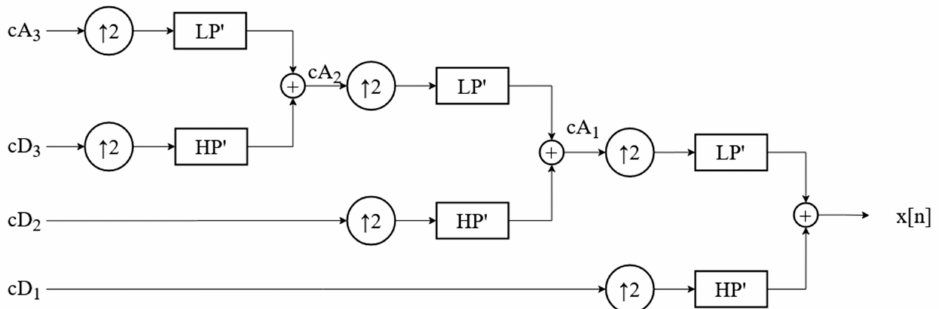
Figure 3. Example of signal reconstruction (3